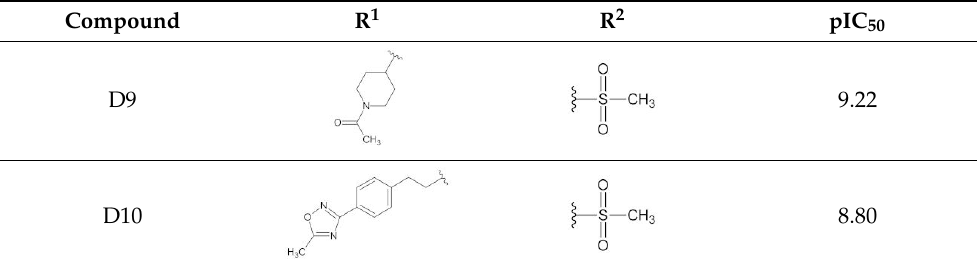
Here, D1 to D10 indicate designed compounds 1 to 10 (D: designed compound).